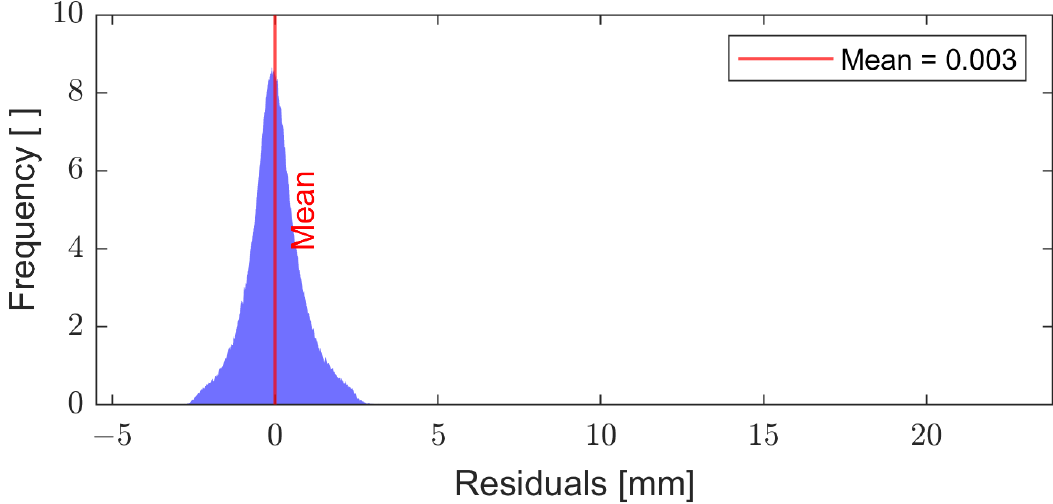
Figure 9. Histogram of approximation error (residuals) for all points and all bootstrap samples. Residuals are defined as the difference between approximation and the